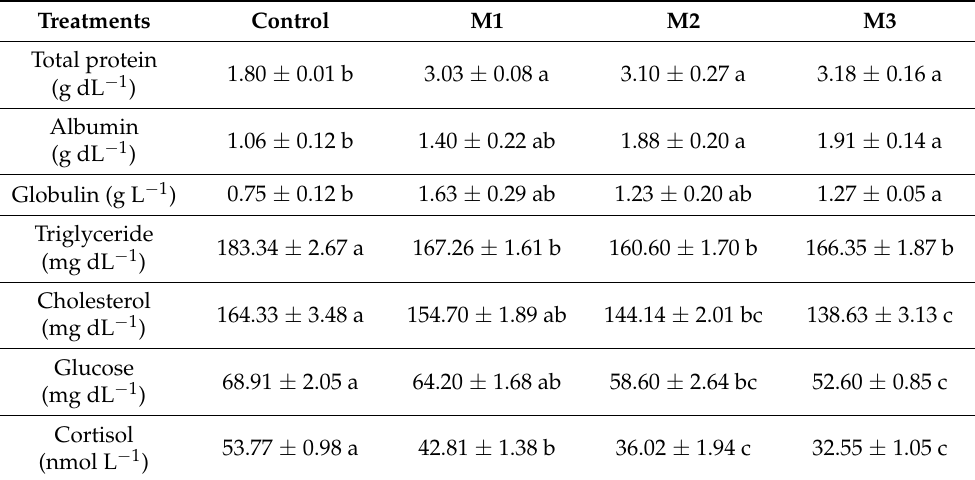
Table 4. Serum biochemical parameters of C. carpio fed diet incorporated with different levels of zero (control), 0.5% (M1), 1% (M2), and 2% (M3) of Myristica fragrans for four weeks. Treatments Control